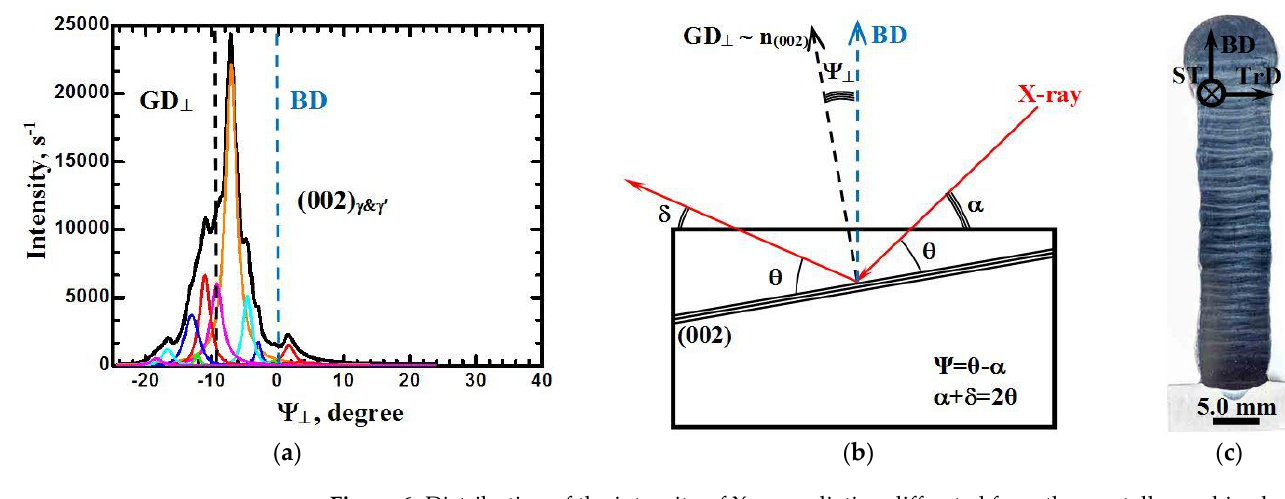
Figure 6. Distribution of the intensity of X-ray radiation diffracted from the crystallographic planes (002) γ - and γ’ -phase as a function of the rocking angle relative to the BD ( a ), X-ray imaging scheme ( b ), and image of the macrostructure ( c ) in a section perpendicular to the ST.